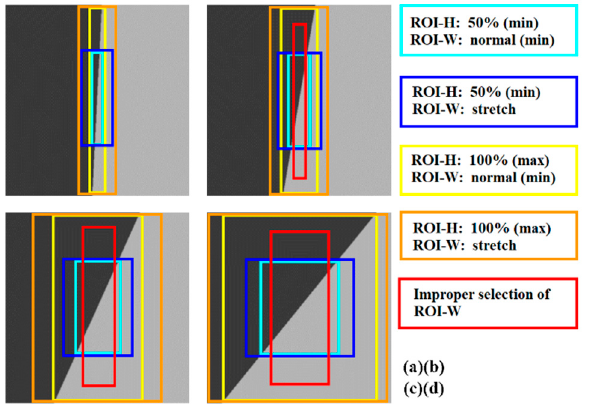
Figure 13. Graphic diagram of ROI extraction at minimum/maximum ROI-H and nor- mal/stretched/improper ROI-W: ( a ) when edge angle is 3 deg, ( b ) when edge angle is 10 deg, ( c ) when edge angle is 25 deg, ( d ) when edge angle is 40 deg.